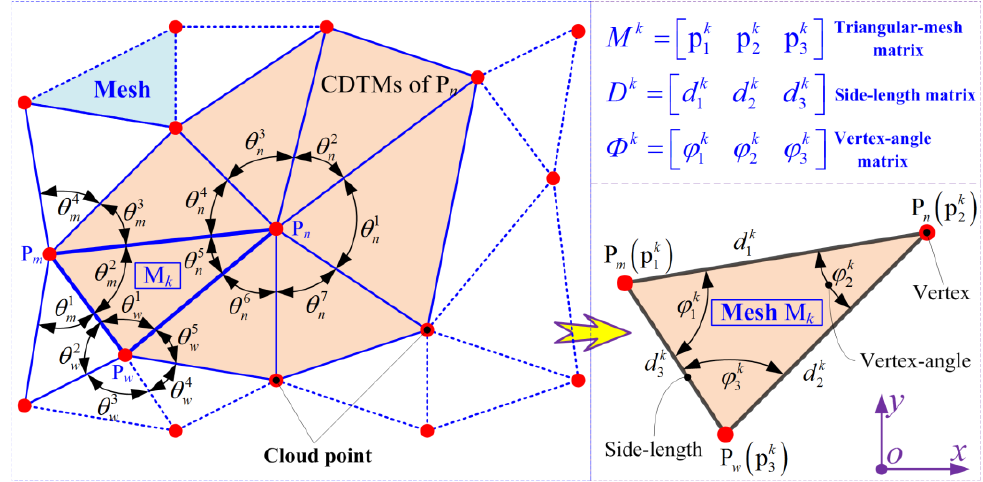
Figure 3. Basic principles of the CDTM-based boundary extraction method for point clouds.